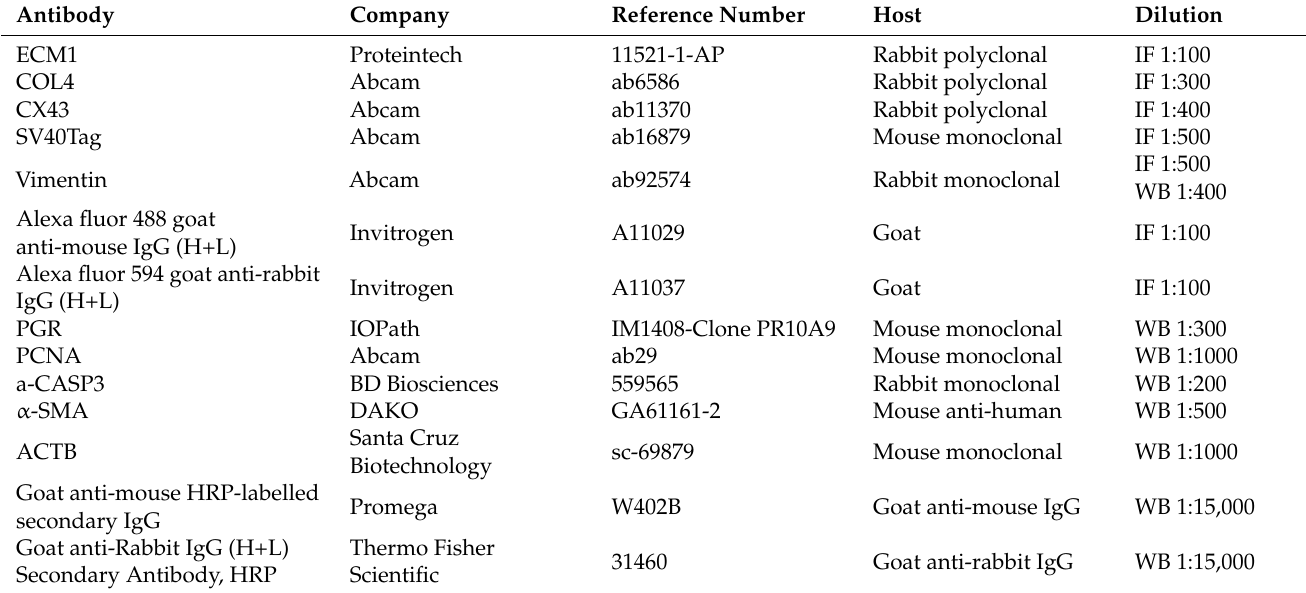
Table 2. List of antibodies used for immunofluorescence (IF) staining and western blot (WB)